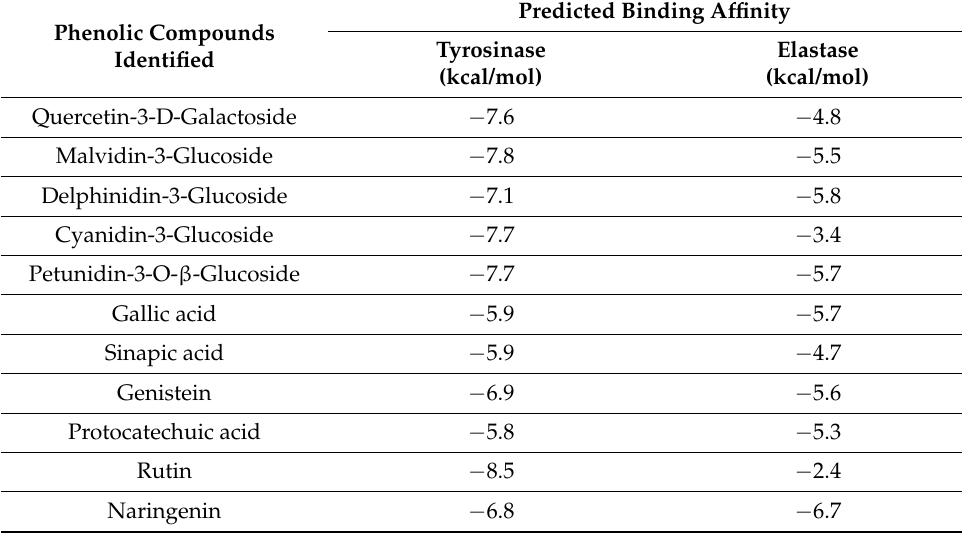
Table 3. Molecular docking